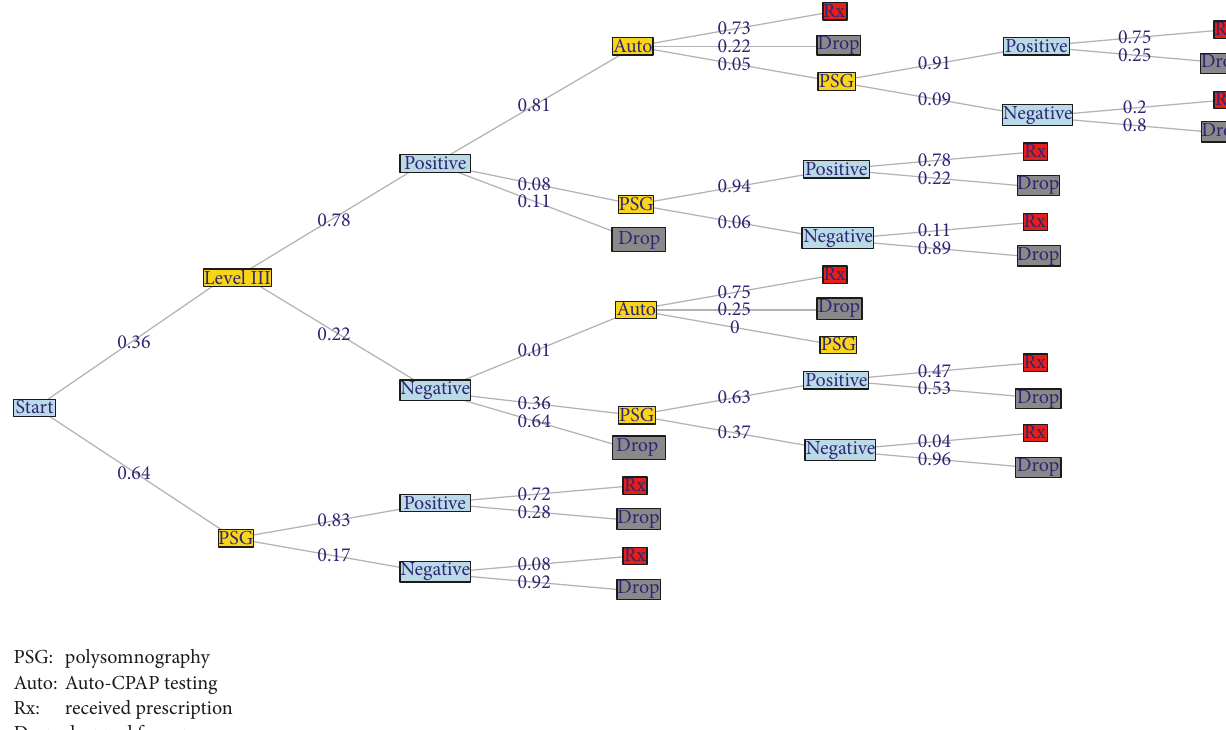
Figure 2: Patient flow through the SDC. The numbers on the lines in the figure indicate the proportion of patients that take that choice. This figure has been slightly simplified, as there is the potential for repeated procedures at most